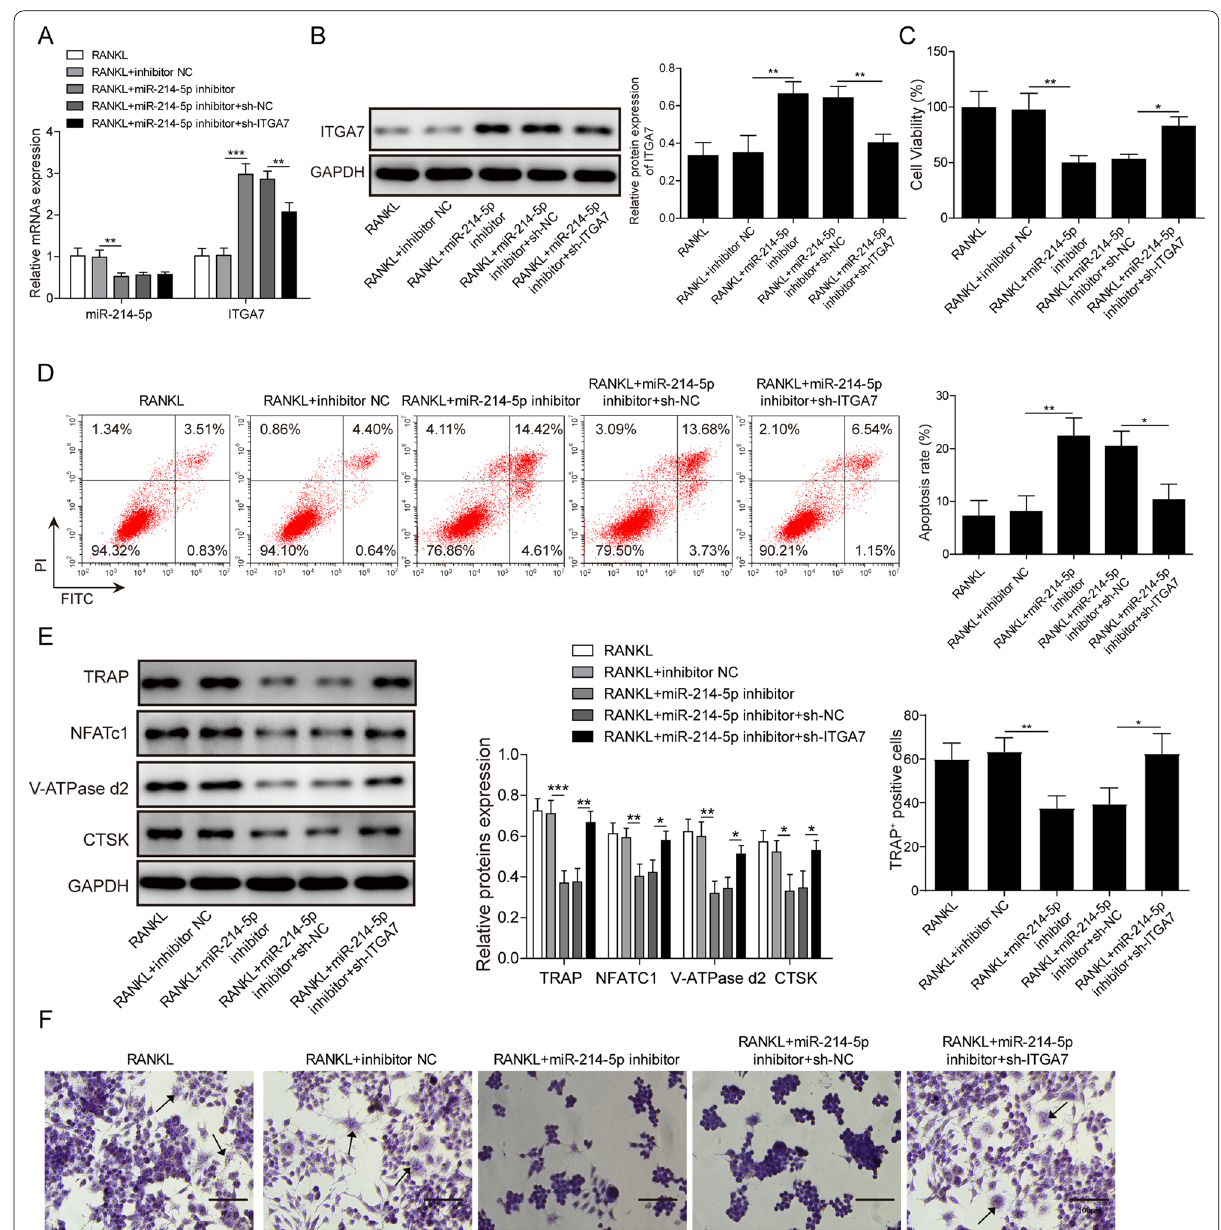
Fig. 5 MiR‑214‑5p downregulation inhibits osteoclastogenesis and ITGA7 knockdown reverses this trend. RAW264.7 cells were treated with miR‑214‑5p mimic/mimic NC with or without sh ITGA7/sh NC. A Expression of miR‑214‑5p and ITGA7 was examined by qRT‑PCR. B Protein level of ITGA7 was examined by western blotting. C Cell viability was evaluated by CCK‑8 assay in each group. D Cell apoptosis was assessed by flow cytometry. E Expression of osteoclast markers was evaluated by western blotting. F TRAP staining results in each group. Experiments were performed for at least 3 times. Data are presented as mean SD. *P < 0.05, **P < 0.01 and ***P < ±